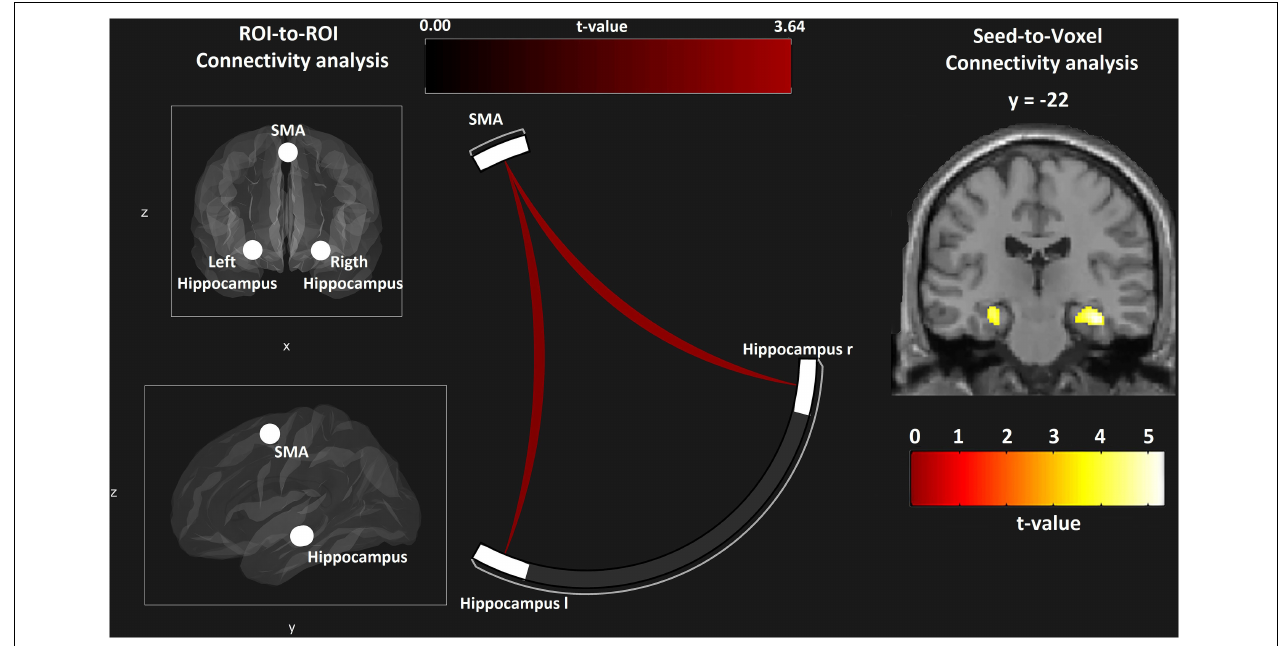
FIGURE 12 | ROI-to-ROI analysis reveals connectivity differences between the two learning groups with both hippocampal regions (left and center panel) . In the seed-to-voxel analysis, selective effects at the hippocampus are suggested, matching the involvement with the VE navigation task (voxel-wise threshold p < 0.001; right panel ).